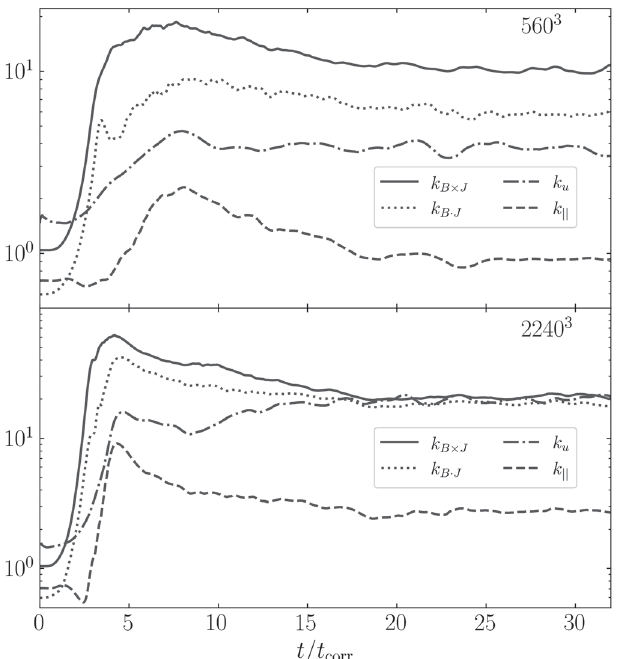
FIG. 9. Time evolution of the characteristic wave numbers ; k ; k ð k B · J B × J Þ describing the magnetic field [see Eq. (19)] and k describing the small-scale structure of the velocity field [see Eq. (20)] at Pm ¼ 10 and resolutions 560 3 and 2240 3 .